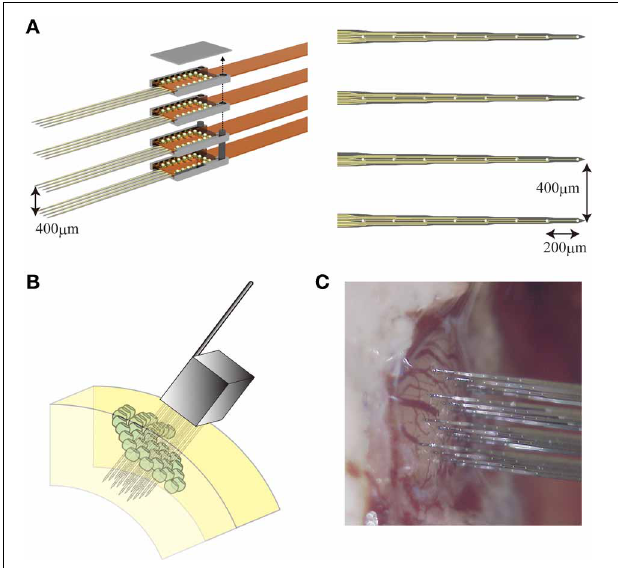
FIGURE 1 | The 3D array. ( A , left) Micro assembly of four planar probes a courtesy of Neuronexus Tech. ( A , right) Each planar probe comprises 32 microelectrodes with 400 μ m inter-shank distance and 200 μ m inter-electrode distance along each shank. An illustration (B) and a photograph (C) of the 3D array right before its implantation into the somatosensory cortex of a rat.